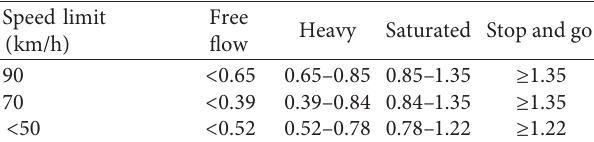
Table 1: Volume/capacity ratio thresholds for the traffic situation determination